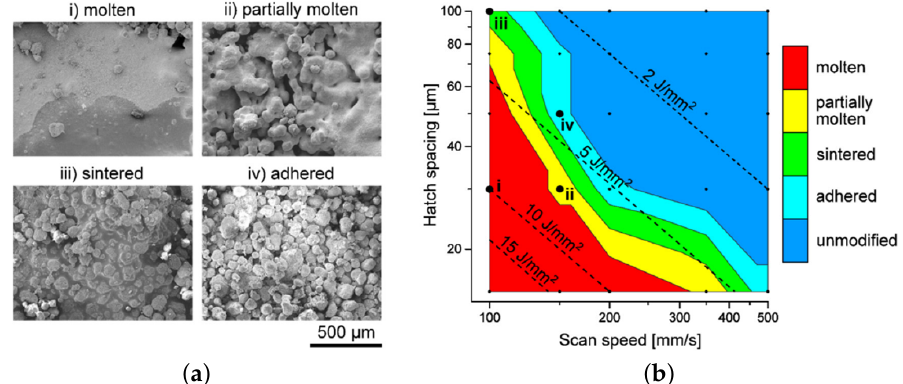
Figure 8. ( a ) Scanning electron microscopy micrographs of four different UHMWPE samples made via SLS printing. ( b ) Characterization of the consolidation of UHMWPE via SLS printing, where the hatch spacing is shown against the scan speed of the laser. Here, a direct correlation between the characterization and the specific energy density is shown. Reproduced with permission [119], Copyright 2021,